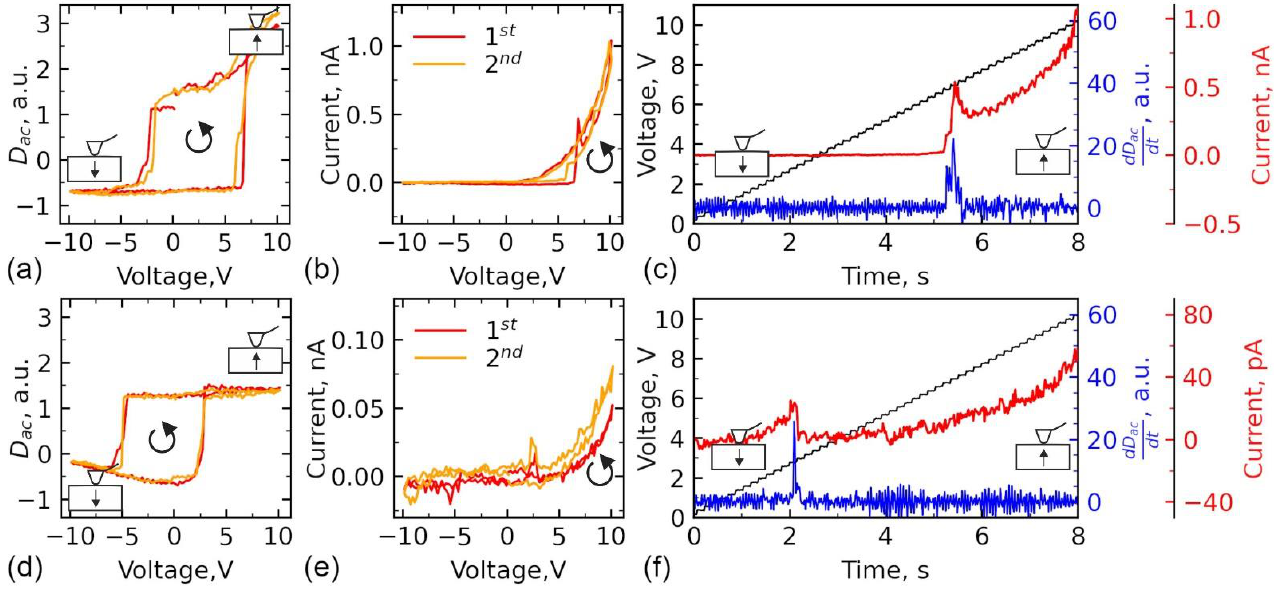
Figure 7. Simultaneous measurements of the piezoresponse (D ac ) and current hysteresis for ( a – c ) positive and ( d – f ) negative built-in surface charge. ( a , d ) Piezoresponse and ( b , e ) current hysteresis loops. ( c , f ) Temporal dependencies of the dD ac /dt — piezoresponse derivative (blue) and current (red). The bypass of the loop is counterclockwise (indicated by the circled arrow). Before the measurements of the hysteresis loop, negative 10 V, 1 s duration triangular-shape pre-pulse was applied to the substrate to set up the direction of the polarization equally upward.